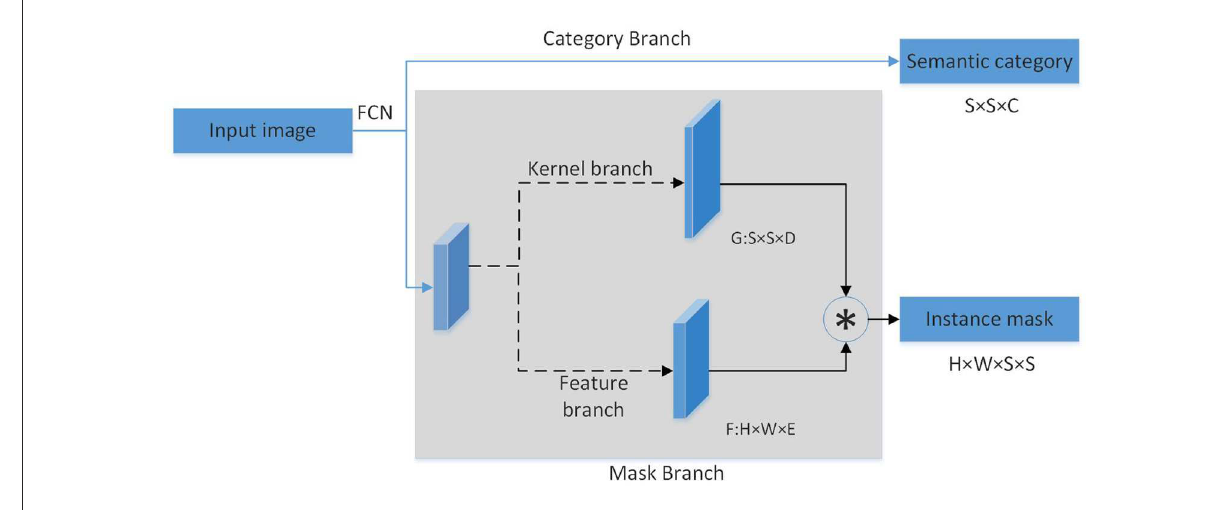
FIGURE2 State semantic region